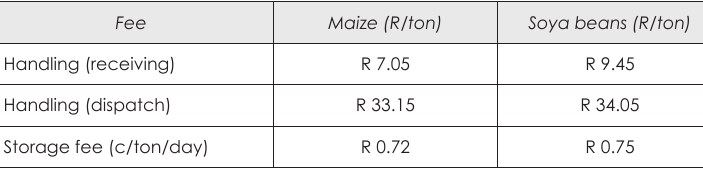
Table 1: Current daily storage rates for silo